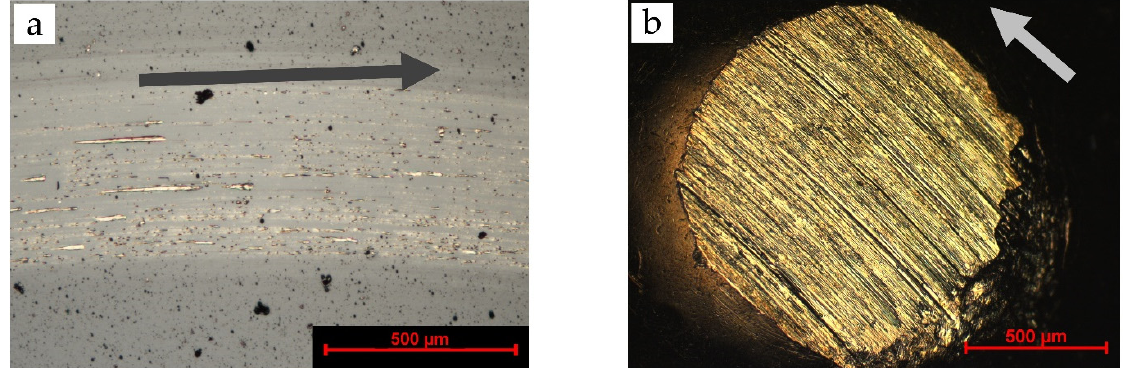
Figure 6. Light microscope images of brass/ta-C sliding experiment under high vacuum showing wear on the ( a ) disc and ( b ) counterbody from the long-term experiment with a sliding distance of 72.0 m. In comparison with the 12.0 m sliding distance, a clear degradation of the disc and counterbody surfaces is visible. The arrows indicate direction of movement of the shown body.